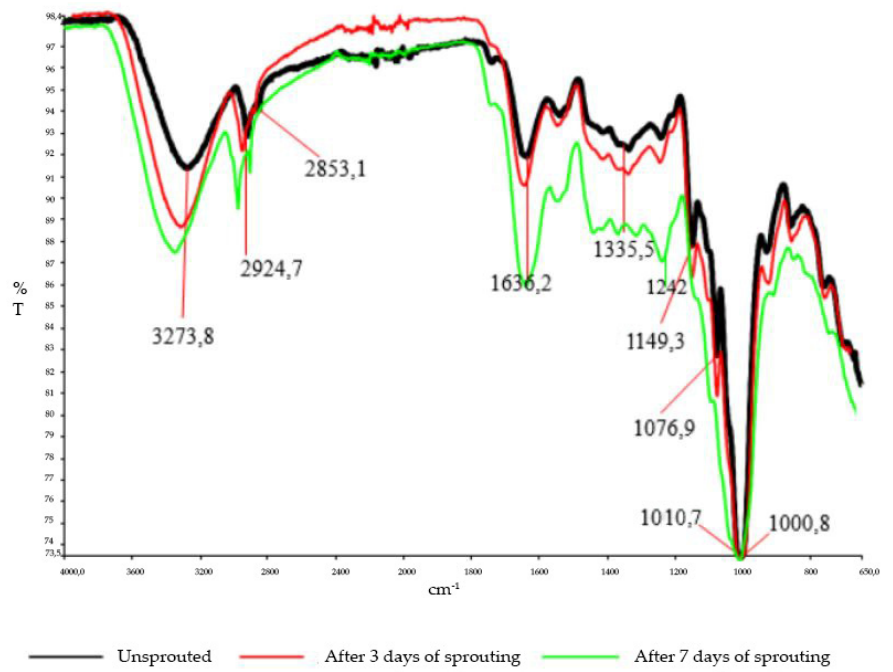
Figure 4. FTIR footprint of bioactive compounds in buckwheat achenes.